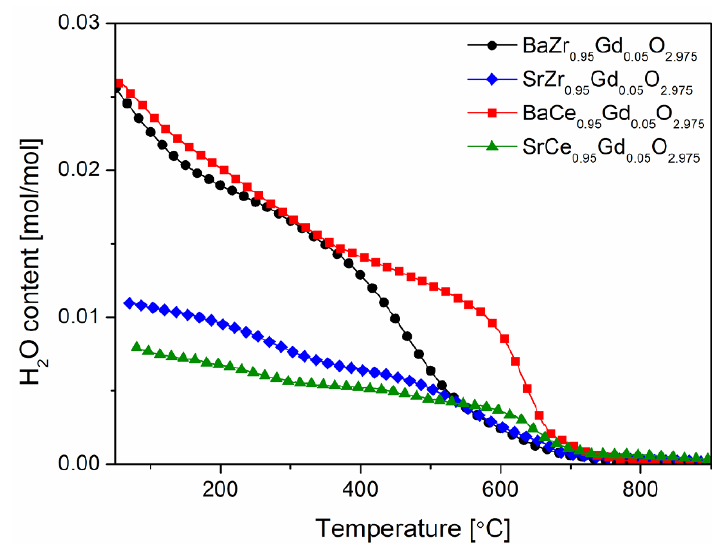
Figure 2. Water desorption profiles calculated from TG